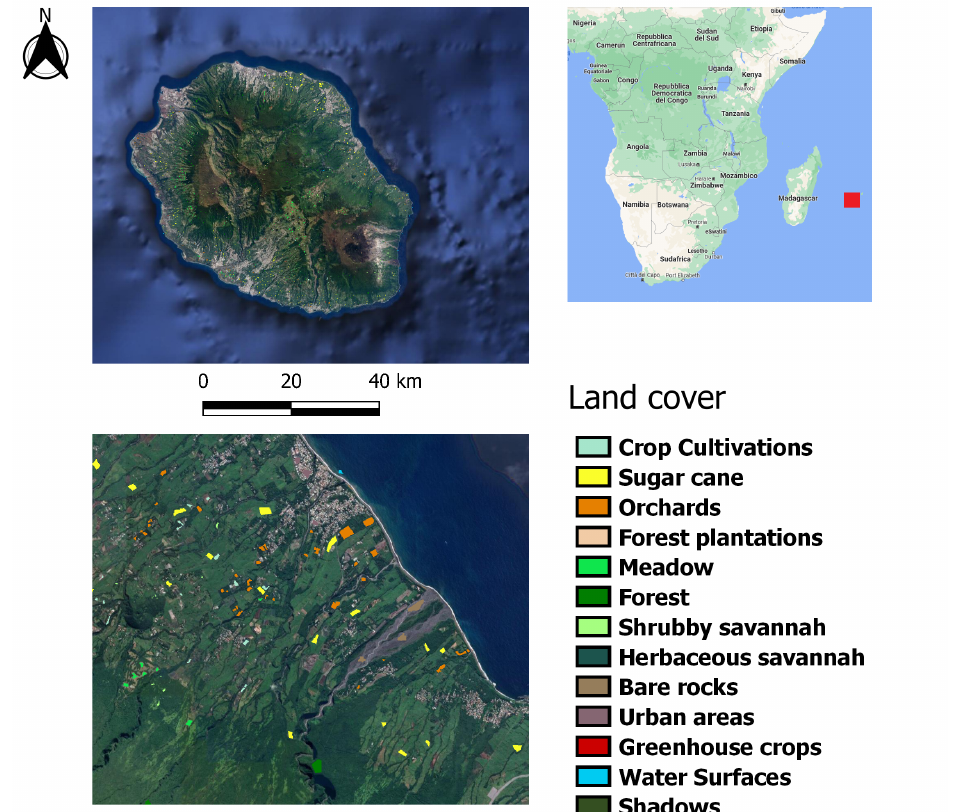
Figure 1. Location of Reunion Island study